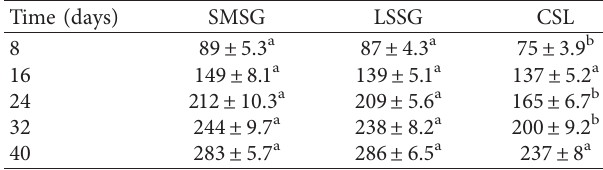
Table 4: The release rate of phenolic compounds (mg/kg) in oil from encapsulated powders produced by SMSG, LSSG, and CSL at levels of 1000